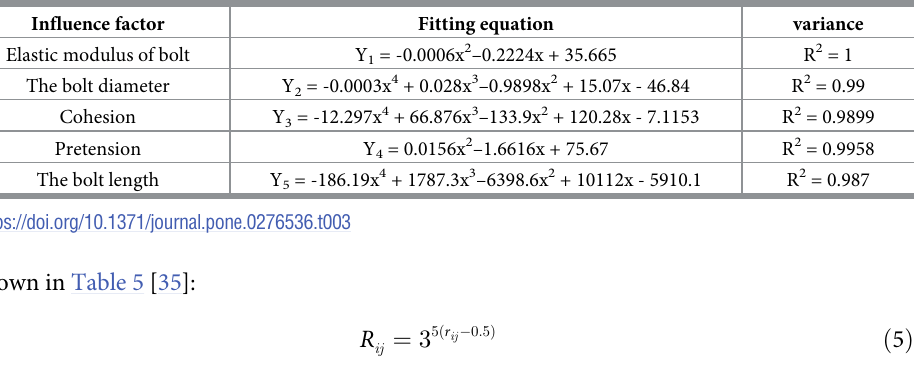
Table 3. Curve fitting equation of β under different factors.